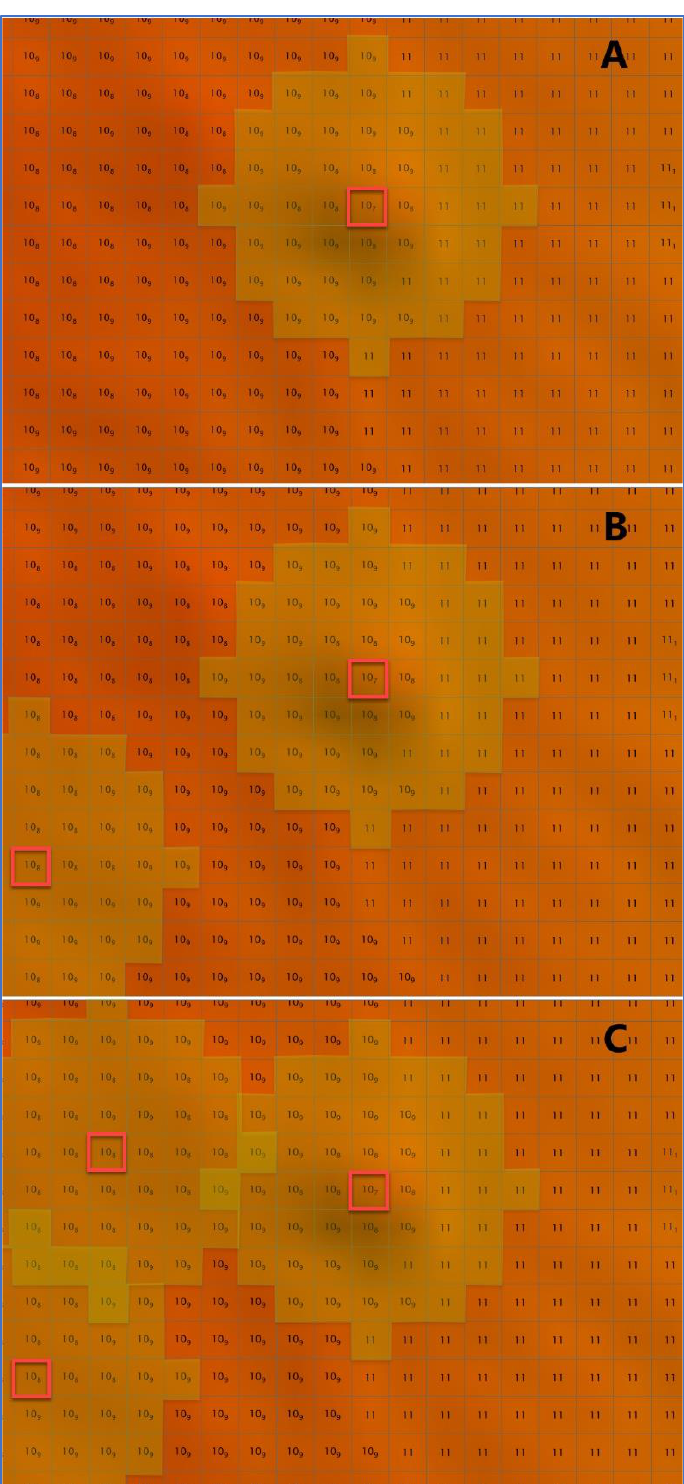
Figure 16. The Moving Window method used in the Sounding Selection tool. First, the area is divided into square window ( A ). The shallowest sounding is then chosen for each area ( B ). The black values are depth values, in meters, from the evaluated grid; when shown, the sub-index represents deci- meters.